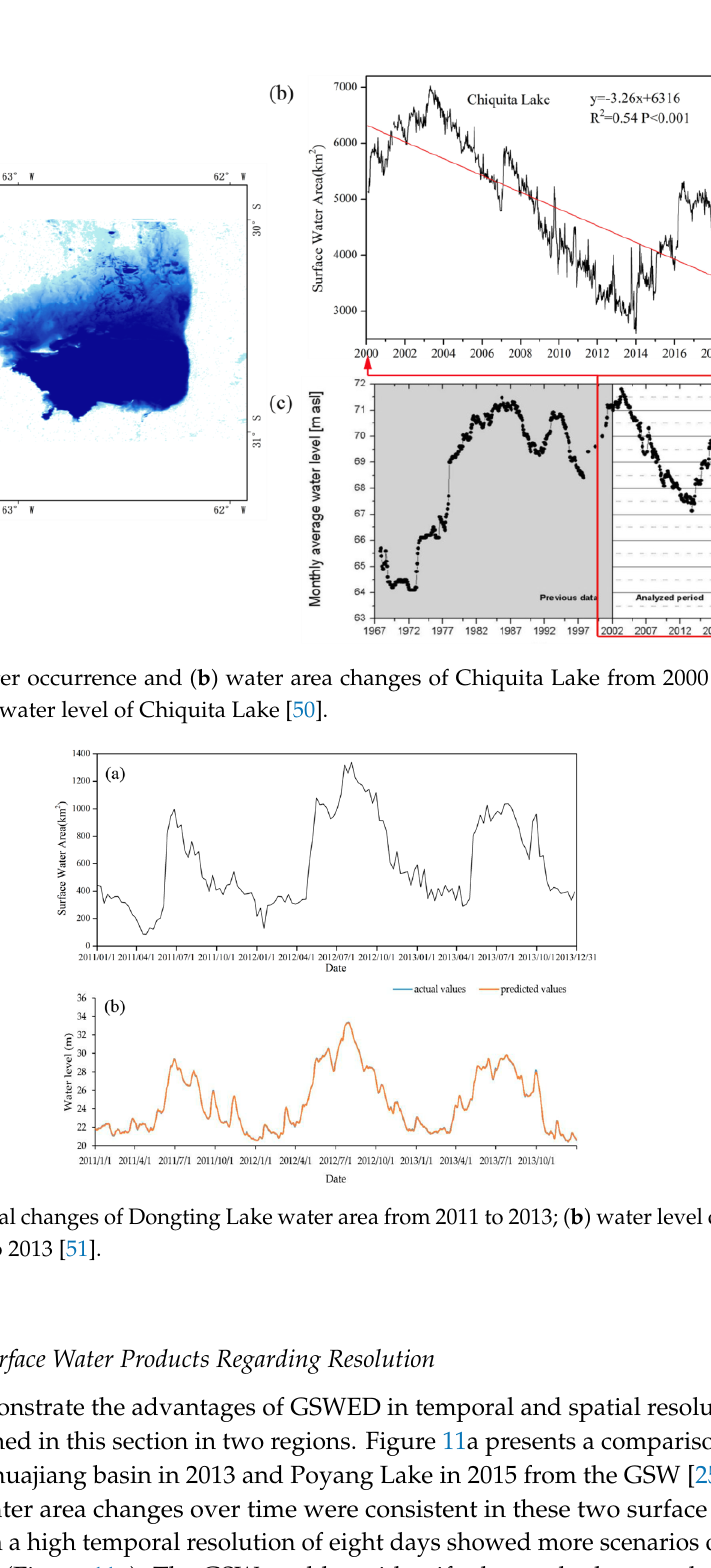
Figure 10. ( a ) Areal changes of Dongting Lake water area from 2011 to 2013; ( b ) water level of Dongting Lake from 2011 to 2013 [51].